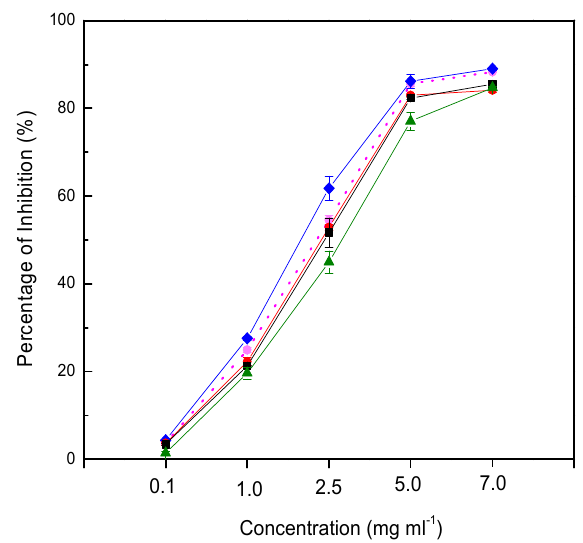
Figure 3. Free radicals by probioticated pomegranate juices at different agitation speeds (non-probioticated juice, dot line; 0 rpm, blue line; 50 rpm, red line; 100 rpm, black line; 150 rpm, green line).